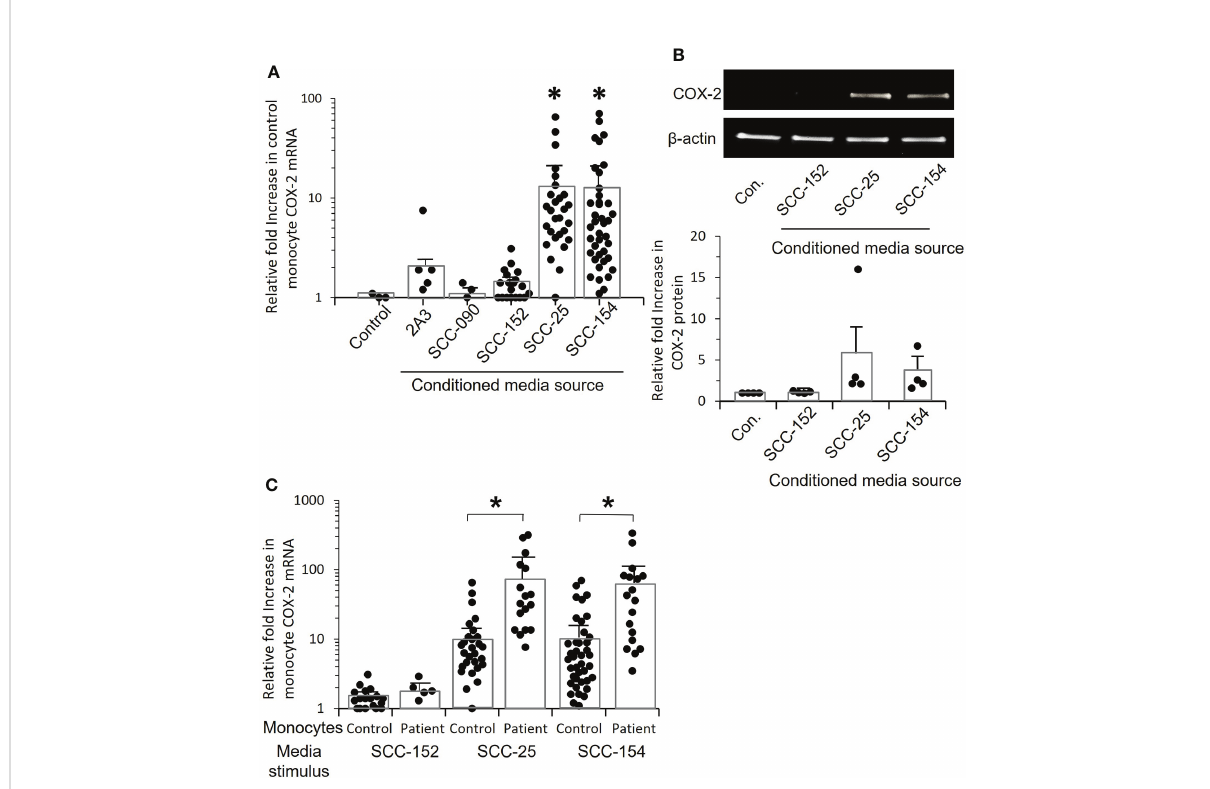
FIGURE 5 Conditioned media from tumor cell lines increase COX-2 mRNA levels in control and OPC monocytes. (A) Monocytes from controls were stimulated for 24 hrs. with conditioned medium from fi ve OPC/oral cancer cell lines, and COX-2 mRNA levels measured by q-RT-PCR. Each dot within a given condition represents a different isolate of monocytes, bars indicate mean ± SD relative to media. There was a statistically signi fi cant increase in COX-2 expression following stimulation with conditioned media from tumor cell lines SCC-25 (*p=0.008) and CC-154 (*p=0.008, Mann-Whitney test). (B) Monocytes from four controls were stimulated with conditioned medium from three of the cell lines, or with fresh media (con.) and cell extracts analyzed by western blot to con fi rm that COX-2 protein is also elevated. Results shown are one representative blot and the quanti fi cation of relative fold increase in COX-2 protein from the four experiments. (C) Monocytes from controls and OPC patients were stimulated with conditioned medium from SCC-152, SCC-25 and SCC-154, or incubated with fresh media (not shown) for 24 hrs. COX-2 mRNA was measured by q-RT-PCR. Each dot within a given condition is a different isolate of monocytes. Bars indicate mean ± SD relative to fresh media. Expression was signi fi cantly increased in the patients ’ monocytes compared to control monocytes when stimulated with conditioned media from SCC-25, (*p=0.003) and SCC-154, (*p=0.008, Mann-Whitney test) but not with conditioned medium from